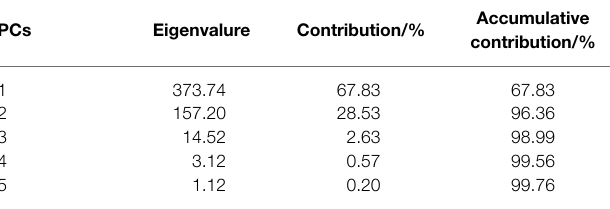
TABLE 4 | The cumulative contribution of some principal components.